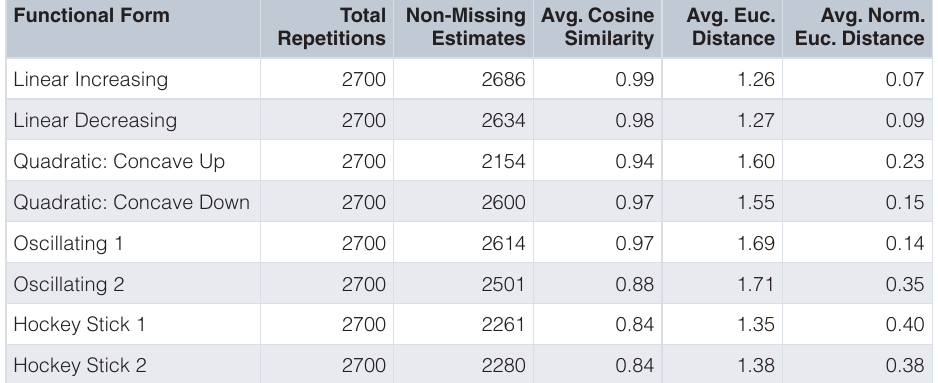
Table 2. Average continuous performance metrics from metaSplines method for data simulated from each respective functional form for a total of 100 repetitions across 27 different parameter settings fixing the correlation structure to be AR(1) with ρ = 0.7. Parameter values used: σ ∊ {1, 2, 4}, n